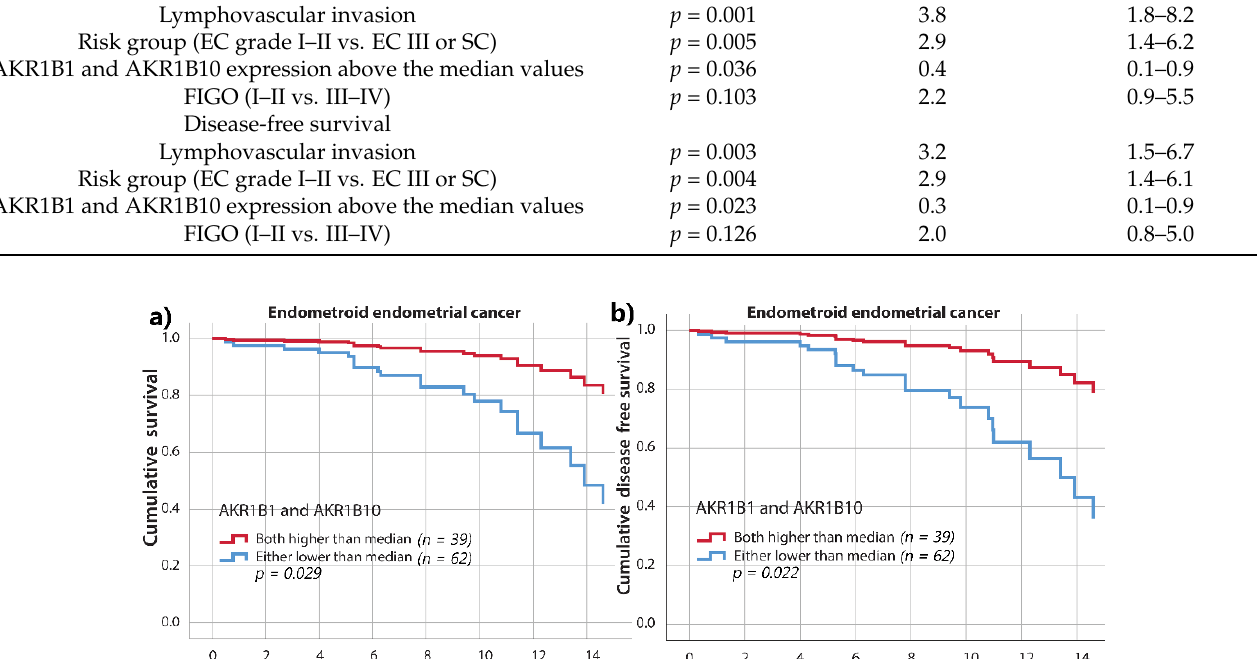
Table 3. Data on multivariant analysis of independent factors predictive of survival.